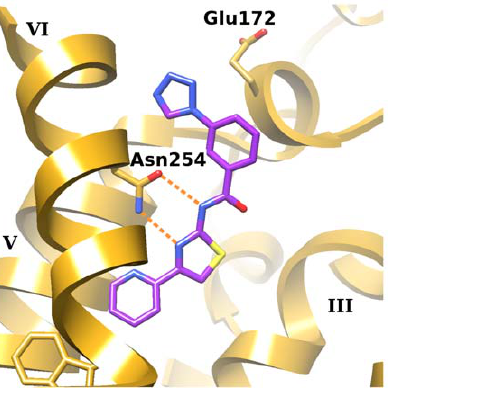
Figure 2. Calculated binding mode of compound 8, the ligand hit with the highest selectivity towards A 1 AR. The protein is model A . Orange dotted lines denote hydrogen bonds formed with Asn254 6.55 . Helices are labeled with roman numerals.